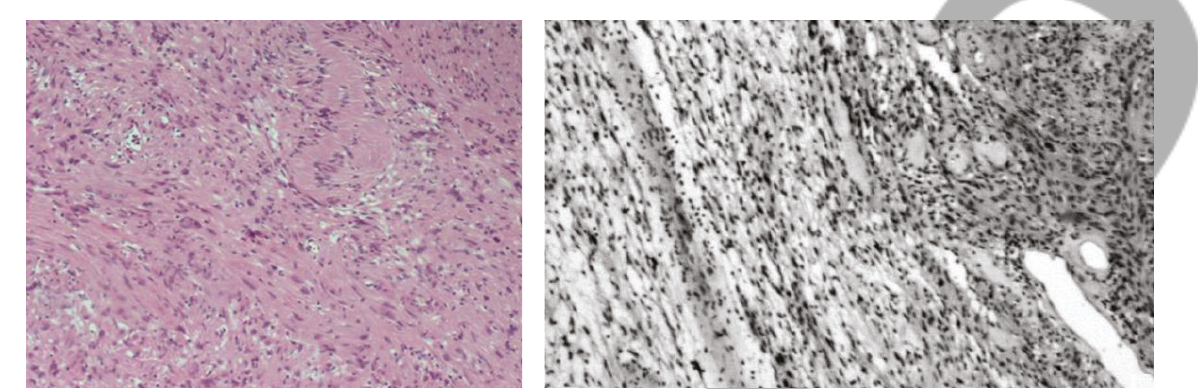
Figure 3: 4 Microscopic view showing benign schwannoma cells, along with alternating Antoni A and Antoni B patterns with fibrinoid degeneration, thrombosis, and hyalinization (H&E, magnification